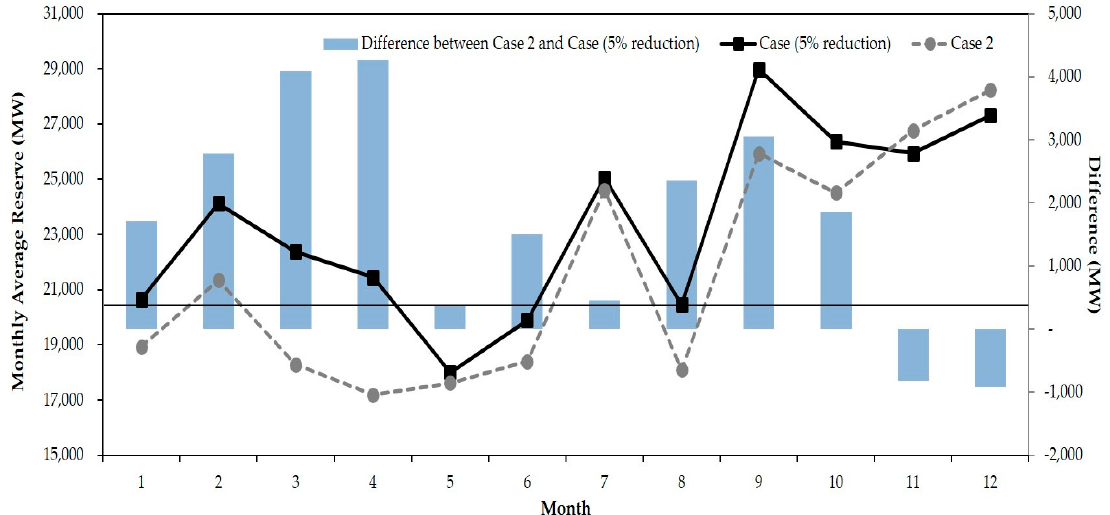
Figure 5. Monthly average supply reserve results for Case 2 and Case with a 5% reduced forecasted daily peak load.